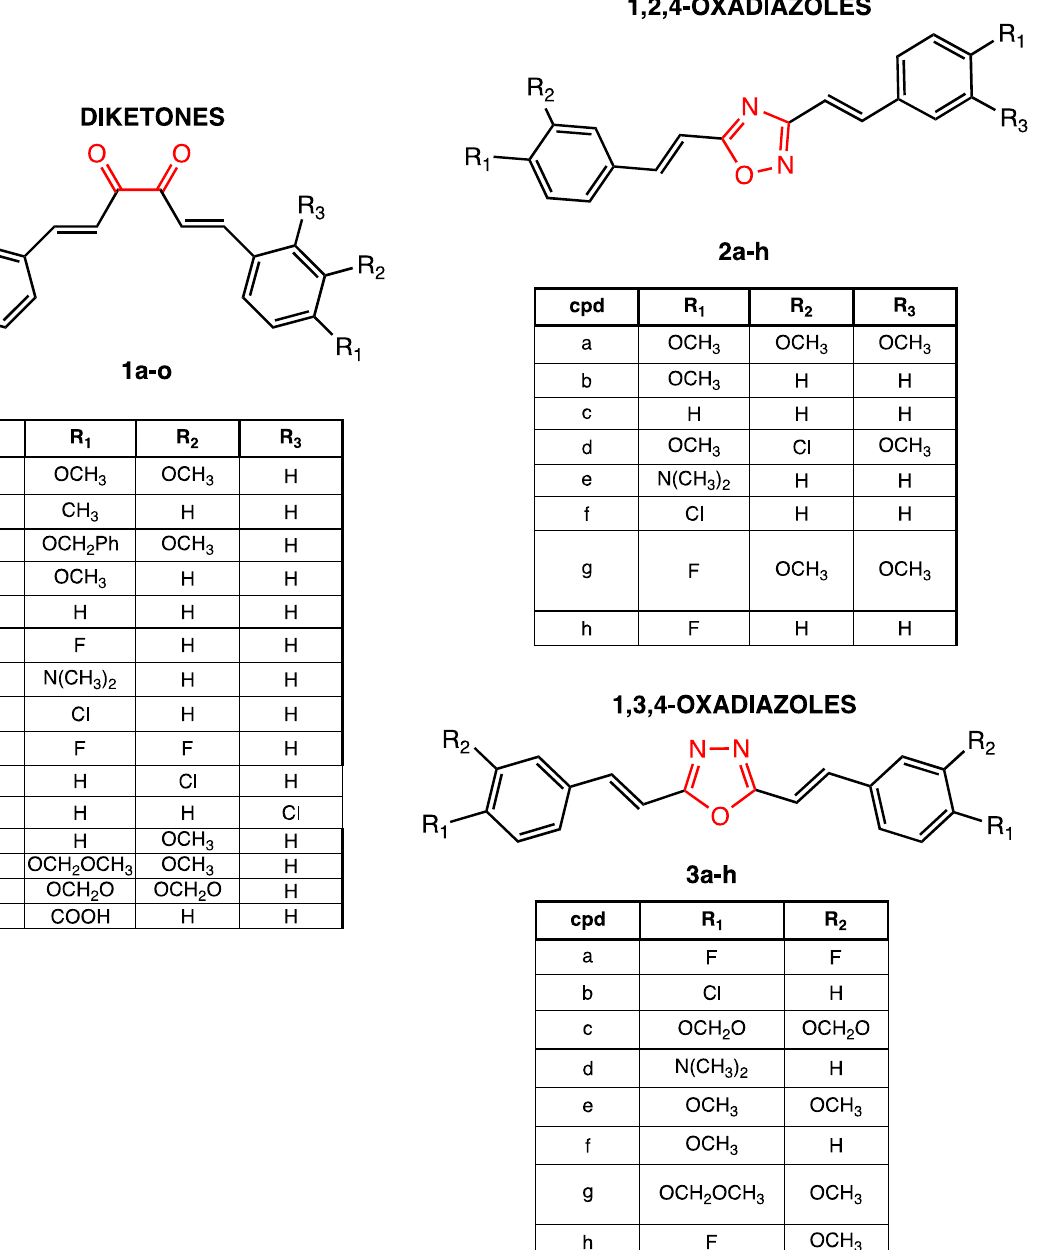
Figure 7. In-house structure database of curcumin-like compounds investigated by the AAP tool. After selecting the molecule database, the next step was to tune the parameters of the AAP protocol. As mentioned earlier, the GI 50 calculation can be targeted to a specific cell line or class of compounds by optimizing the parameters N, G, and Z. In this light, curcu- min, tested by NCI (NSC code 32982) and included in the training set (NCI2014DB), was selected as a reference compound to determinate the best combination of parameters for the CL module. The tuning was performed with the parameters in the ranges 250 < N < 800 and 50 < Z < 100 while considering a, b, or c for the G function. Eighteen runs were started, following the procedure described above for the internal validation (the combi- nations are reported in Table 1). Consequently, the total absolute deviations from the ex- perimental GI 50 values were calculated for each run, and the set of N = 760, Z = 50, and G = c was identified (total |DTV(GI 50 )| = 0.44) and applied to the AAP tool for the selected database (see Supporting Information S10).